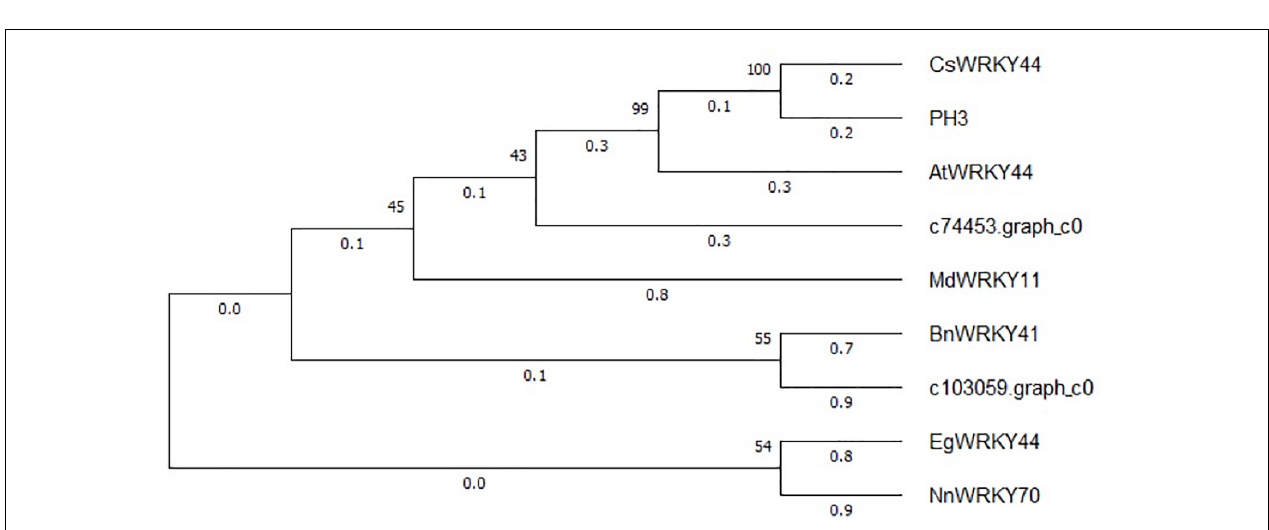
FIGURE 7 | Expression characteristics of two selected AP2 in Freesia hybrida ‘Red Passion’ (RP). RP0, RP in the green bud stage; RP1, RP in budding stage; RP2, RP in early flowering stage; and RP3, RP in flowering stage. The leaf was chosen as a calibrator sample of c97095.graph_c0 (A) . Root was chosen as a calibrator sample of c101694.graph_c0 (B) . Lowercase letters stand for the significance of difference at 0.05 level.